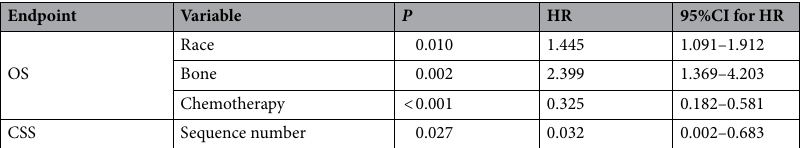
Table 3. Multivariable Cox regression analysis of independent prognostic factors for OS and CSS in elderly patients with de novo mNPC.